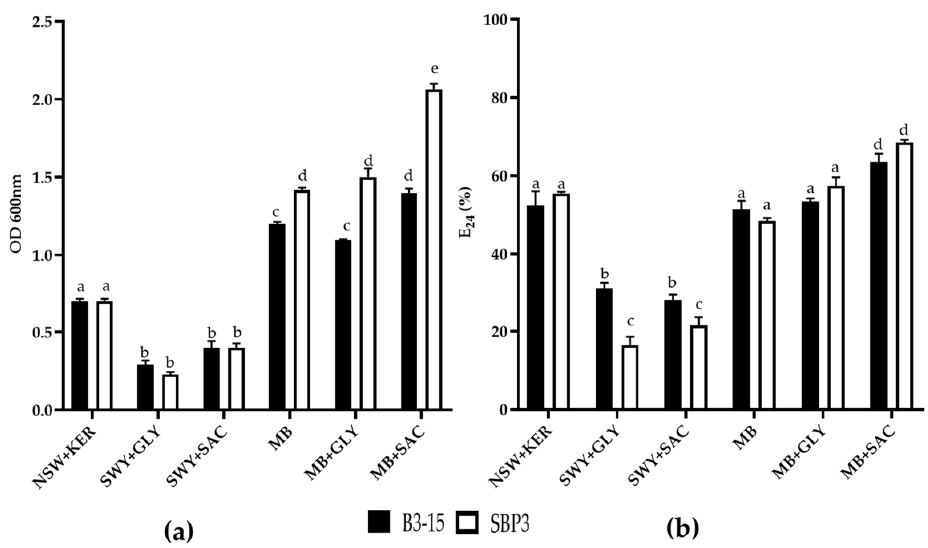
Figure 2. Growth of B3-15 and SBP3 strains (OD 600 nm ) ( a ) and emulsifying index (E 24 %) of their cell-free supernatants (CFSs) ( b ) with kerosene (1:1 v / v ), obtained in different media after incubation at 45 ◦ C for 48 h. NSW + KER, natural seawater plus 2% kerosene; SWY + GLY, seawater plus yeast extract and glycerol (3%); SWY + SAC, seawater plus yeast extract and saccharose (3%); MB, marine broth; MB + GLY, MB plus glycerol (3%) and MB + SAC, marine broth plus saccharose (3%). Data are expressed as averages and standard deviations (n = 3). The lowercase letters above the bars denote groups significantly different by ANOVA ( p < 0.05).